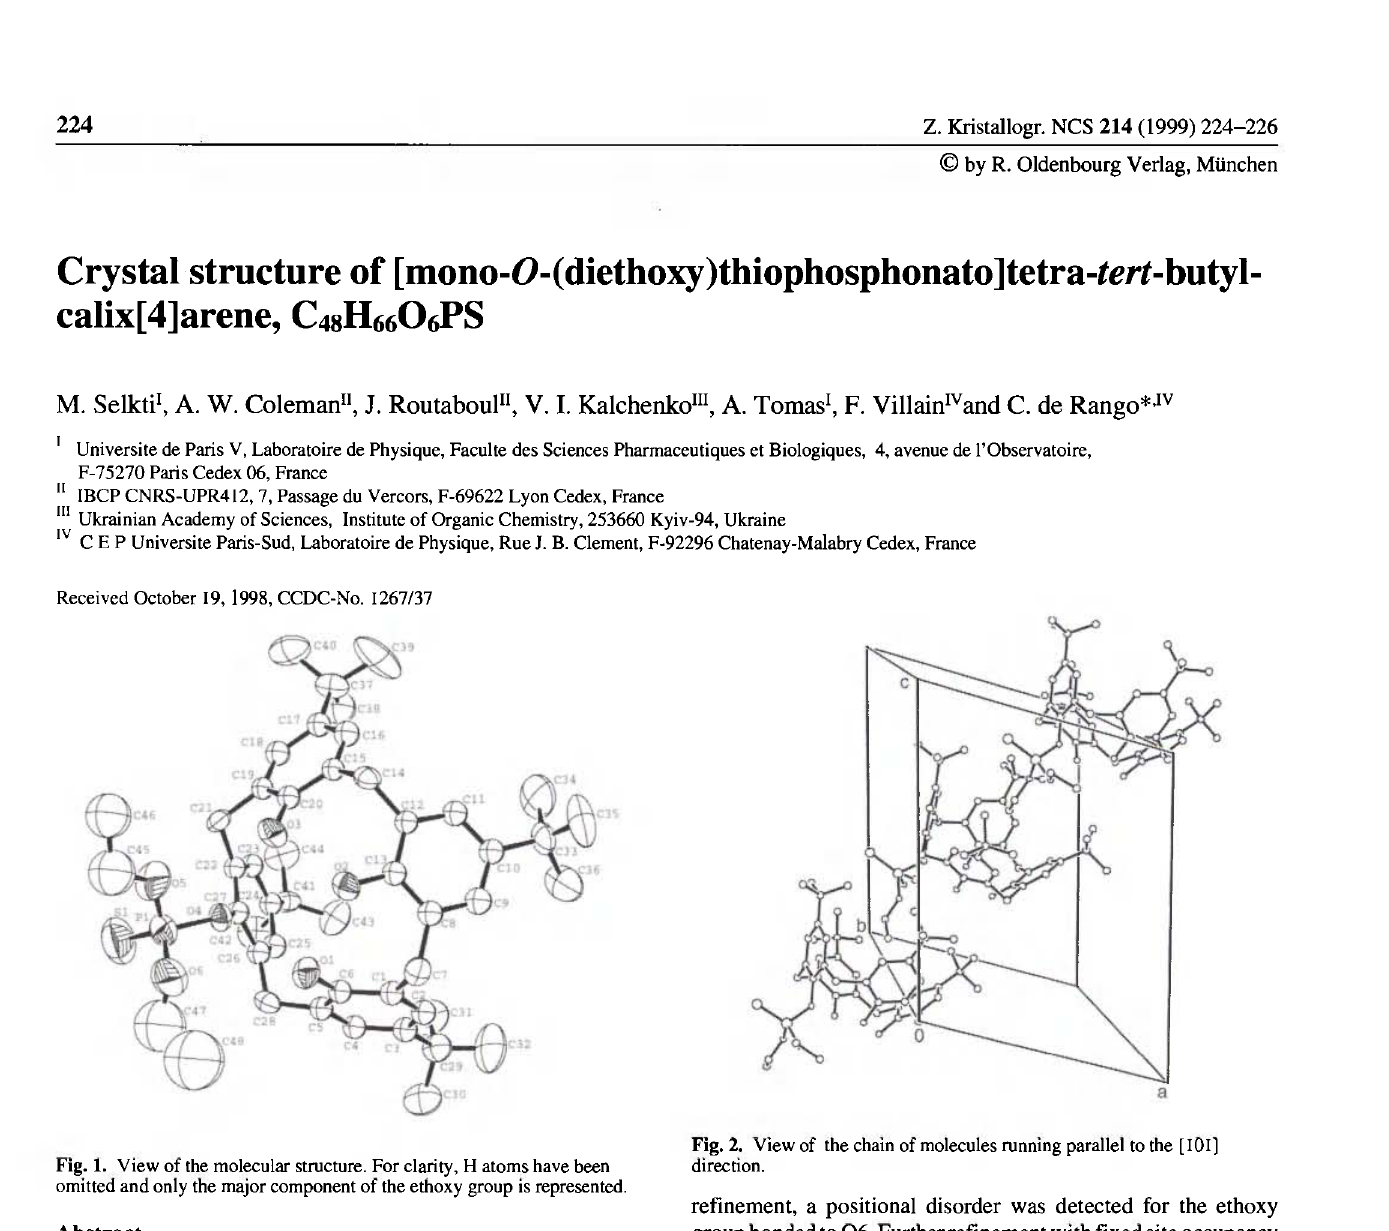
Fig. 1. View of the molecular structure. For clarity, Η atoms have been omitted and only the major component of the ethoxy group is represented.